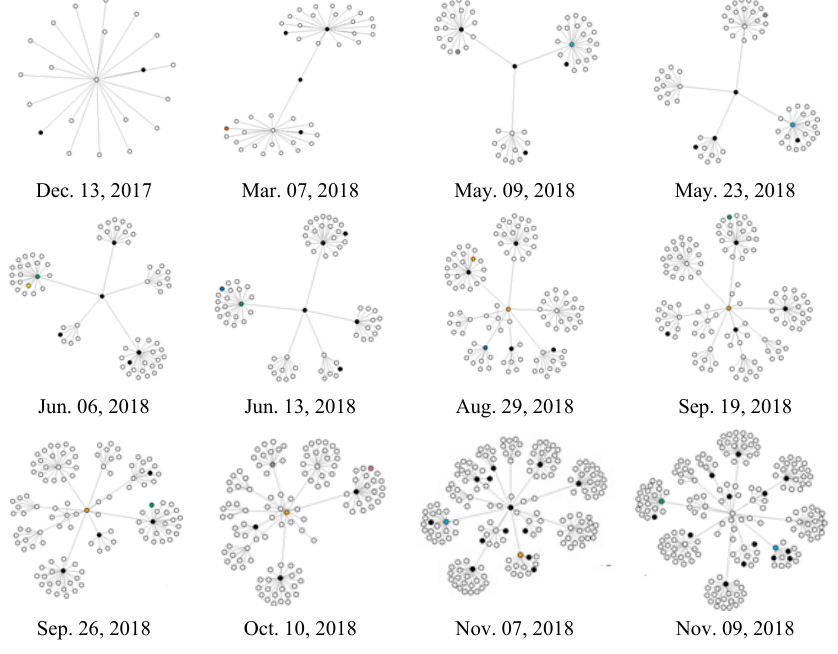
Figure 7. The Tweet (TW) propagation tree of real news over time.